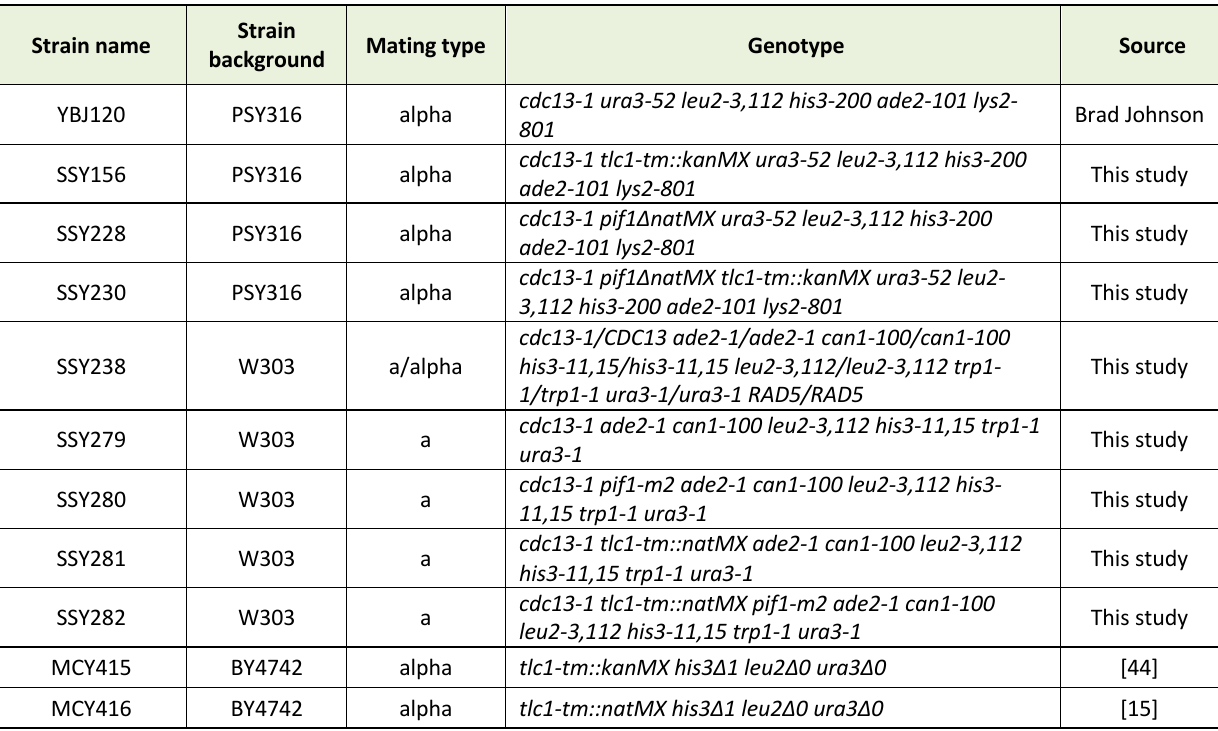
TABLE 1. Yeast strains used in this